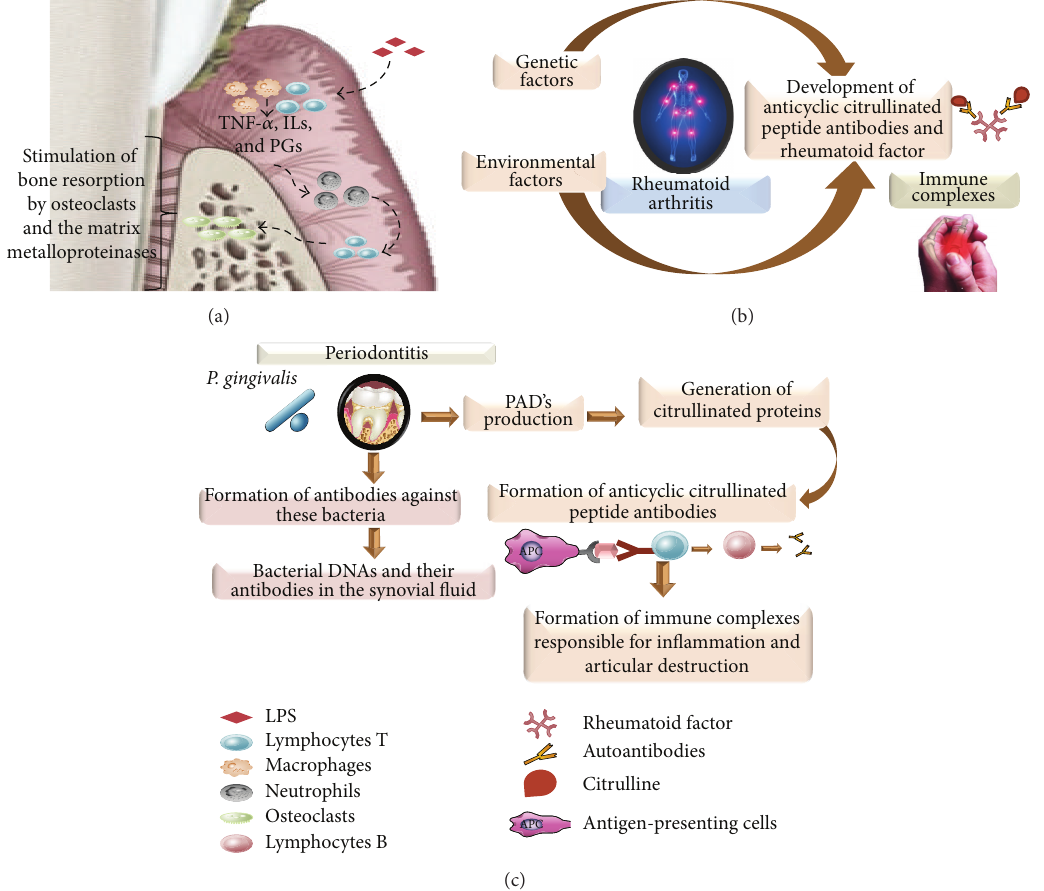
Figure 1: Scheme on the relationship between periodontitis and rheumatoid arthritis. (a) Pathogenesis of periodontitis and the effects promoted by lipopolysaccharides present in periodontopathogens. (b) The involvement of genetic and environmental factors in the development of rheumatoid arthritis. (c) Possible mechanisms that explain the relationship between rheumatoid arthritis and